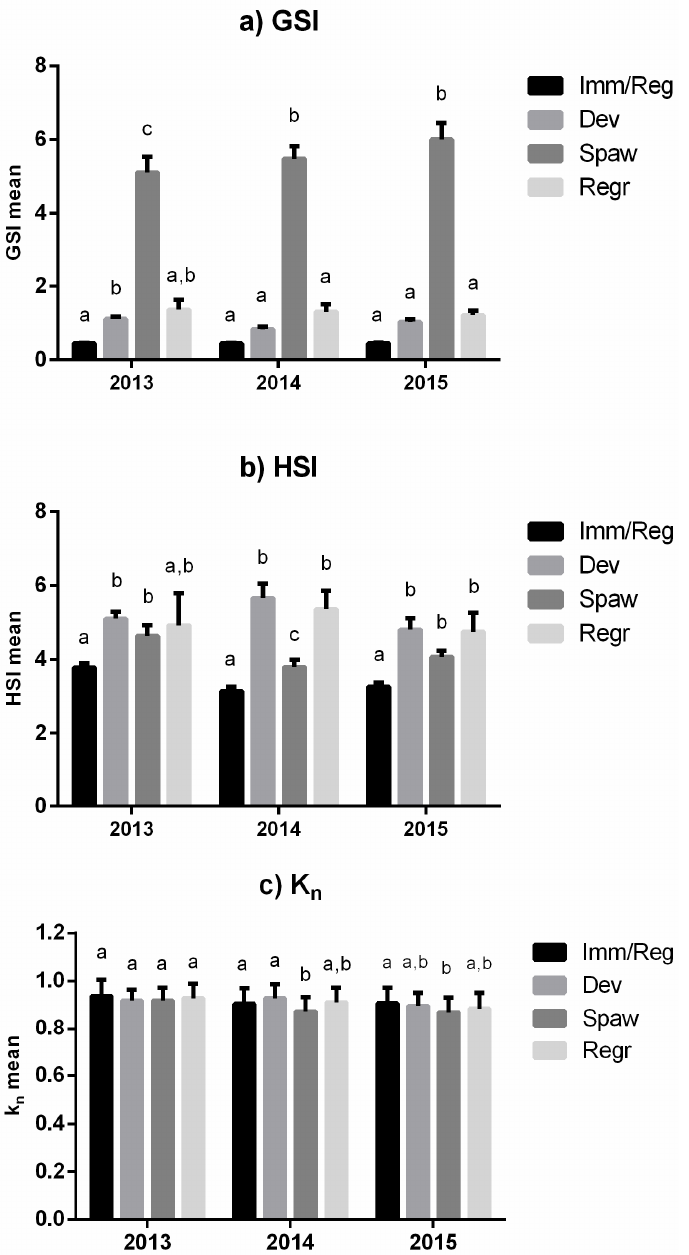
Figure 5. Values of the GSI ( a ), HSI ( b ) and K n ( c ) for females of European hake per ovarian stages for three years. Imm/reg, includes individuals in immature and regenerating stages; dev, developing; spaw, spawning capable; regr, regressing. The letters indicate a statistically significant difference among groups ( p < 0.05) determined by Tukey’s multiple comparison test.